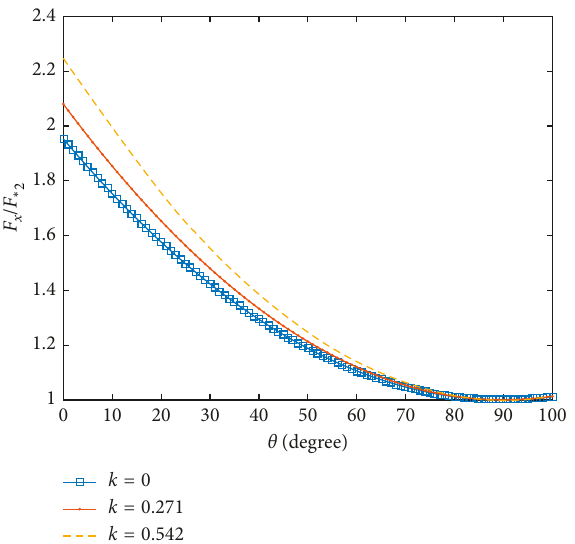
x and angle θ for / c ( 2 ) . 44 44